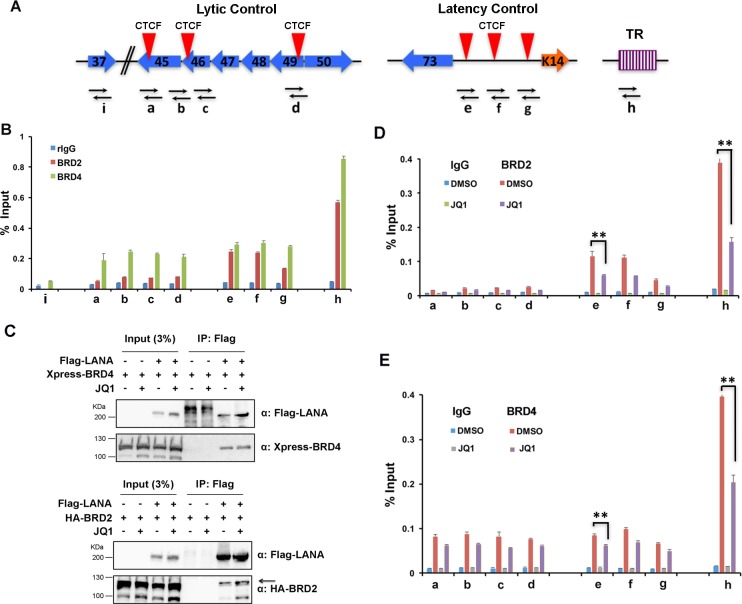
Interaction of BRD2 and BRD4 with KSHV latent episomes.(A) Schematic of KSHV genome regulatory regions tested by ChIP assay and primer positions a-i. Red triangles represent CTCF binding sites and TR is terminal repeats. Open reading frames for KSHV gene are indicated. The lytic control region (primers a-d) is considered the region between ORF45 and ORF50. The latency control region (primers e-g) is considered as the region encompassing ORF75 to K14. The terminal repeat (TR) contains high affinity LANA binding sites (primer h). (B) ChIP assay in BCBL1 cells with antibodies to BRD2 (red), BRD4 (green), or control IgG (blue) at primer position a-i as indicated. (C) CoIP assay for FLAG-LANA interaction with Xpress-BRD4 (top panel) or HA-BRD2 (lower panel) in the presence or absence of 4 μM JQ1. 293 cells were transfected with FLAG-LANA or FLAG-Vector and treated with 4 μM JQ1 or 1% DMSO for 24 hrs as indicated with input extract (left lanes) or after FLAG-IP (right lanes), as indicated. FLAG-IPs were then probed by Western blot with antibody to FLAG (LANA) or to Xpress (BRD4, top panel), or HA (BRD2, lower panel). (D) BCBL1 cells treated daily with 1% DMSO, or 4 μM JQ1 for 72 hrs were assayed by ChIP with antibody to BRD2 and assayed with primers a-h. (E) Same as in panel D, except with antibody to BRD4. Error bars are sdm and ** P < .01.